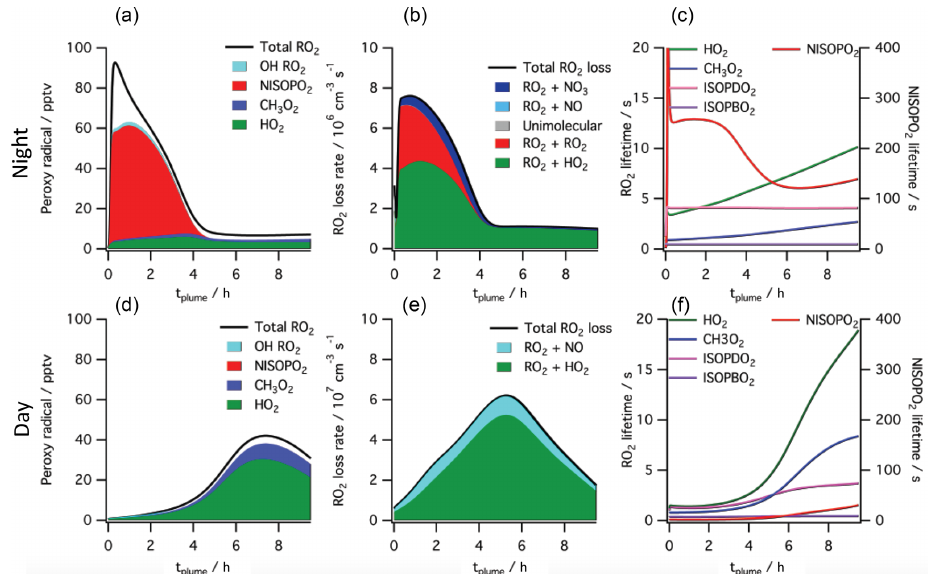
Figure 7. Simulated peroxy radical concentration (a, d) , loss rates (b, e) , and lifetime (c, f) , using the MCM v3.3.1 chemical mechanism, for conditions typical of a nighttime intercepted power plant plume (a–c) and the same plume initial conditions run for daytime simulation ( d–f , local noon occurs at 5h). Included are total peroxy radical concentration and losses, as well as the highlighted subclasses HO 2 , CH 3 O 2 , total nitrooxy-isoprene-RO 2 and the total hydroxy-isoprene-RO 2 produced from OH oxidation. The righthand panels show HO 2 , CH 3 O 2 and the dominant hydroxy-isoprene-RO 2 ISOPBO 2 and ISOPDO 2 ( β -hydroxy-peroxy radicals from OH attack at carbons 1 and 4, respectively) lifetime on the left axis and nitrooxy-isoprene-RO 2 on the right axis, showing nighttime lifetimes an order of magnitude longer than daytime for this NO 3 + isoprene derived RO 2 radical (NISOPO 2